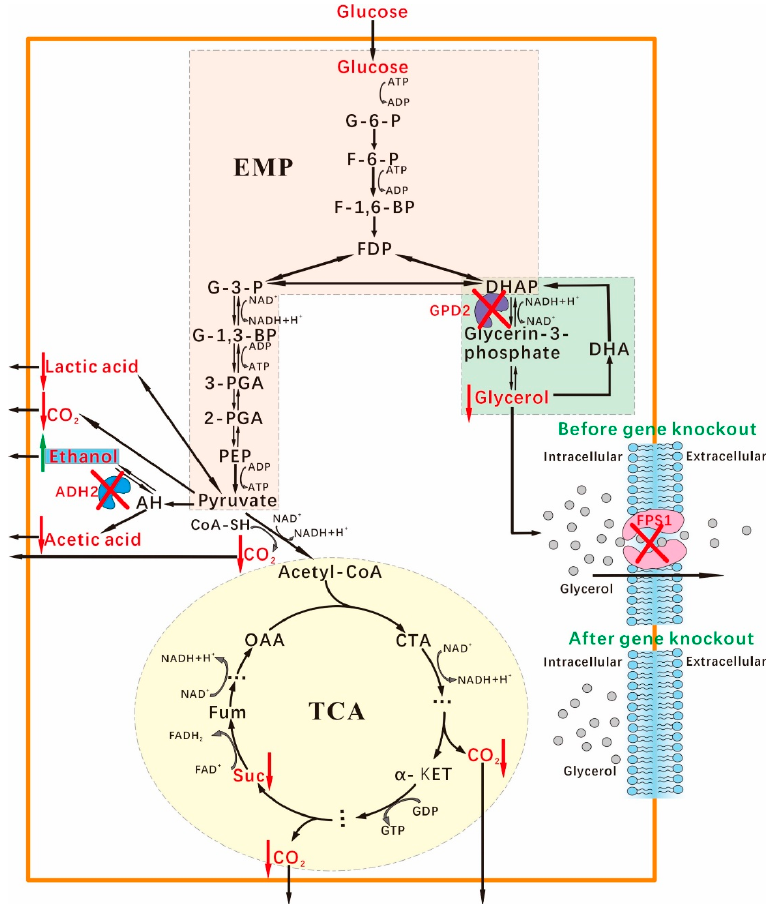
Figure 15. Change of glucose metabolic pathway in SCGFA mutant. SCGFA GPD2 Δ FPS1 Δ ADH2 Δ was constructed by the GPD2 , FPS1 , and ADH2 deletion using the CRISPR-Cas9 approach. The yield of ethanol was increased in SCGFA with the content decrease of the by-products of glycerol, lactic acid, acetic acid, succinic acid, and CO 2 .